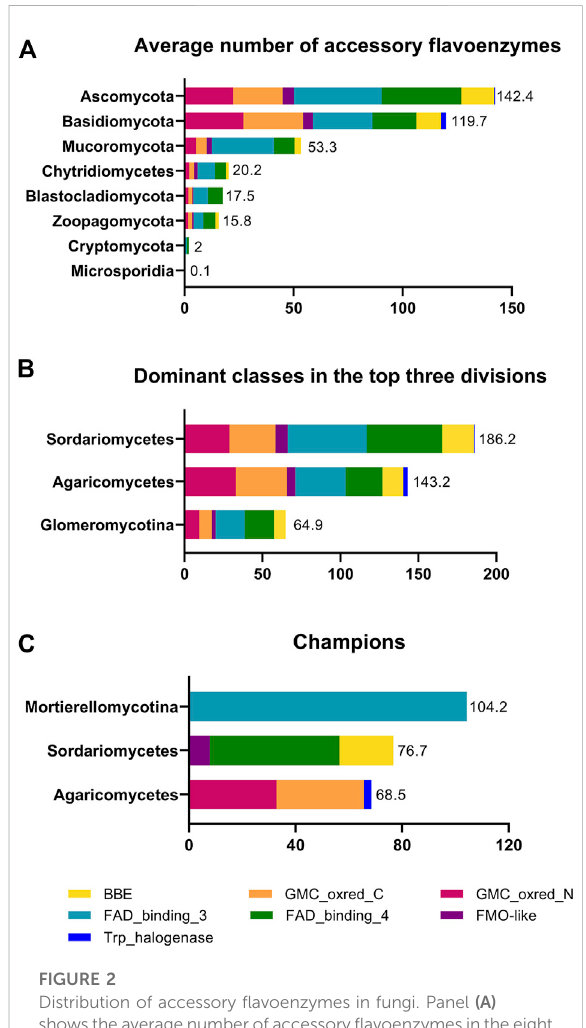
FIGURE 2 Distribution of accessory fl avoenzymes in fungi. Panel (A) showstheaveragenumberofaccessory fl avoenzymesintheeight fungal divisions. Panel (B) shows the classes with the highest average number of accessory fl avoenzymes for the divisions Ascomycota, Basidiomycota, and Mucoromycota, i.e., Sordariomycetes, Agaricomycetes, and Glomeromycotina, respectively. Panel (C) highlights the classes with the highest average number of accessory fl avoenzymes in fungi. The data used in the fi gure was extracted from Table